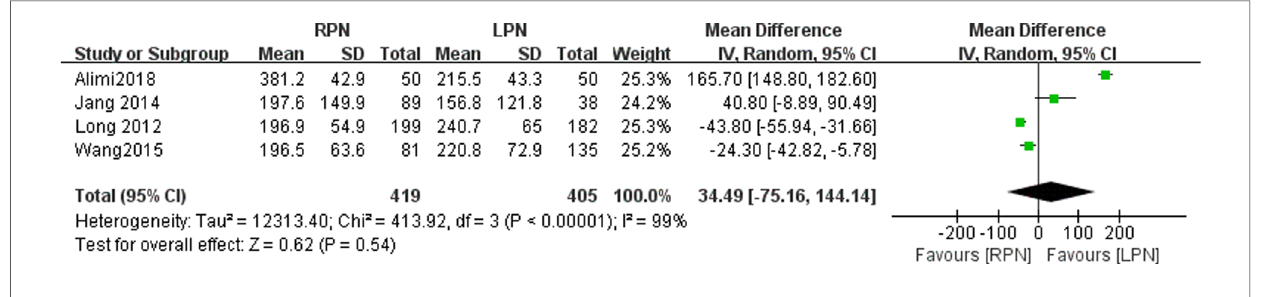
FIGURE 3 Forest plot for estimated blood loss between the RPN and LPN.